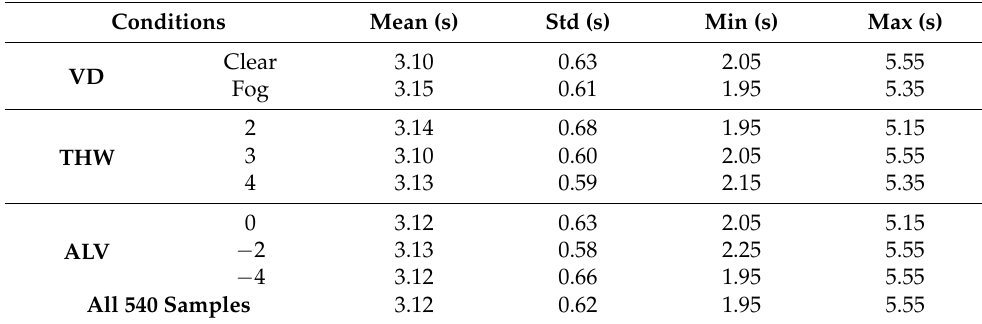
Table 2. Summary of the takeover reaction time.